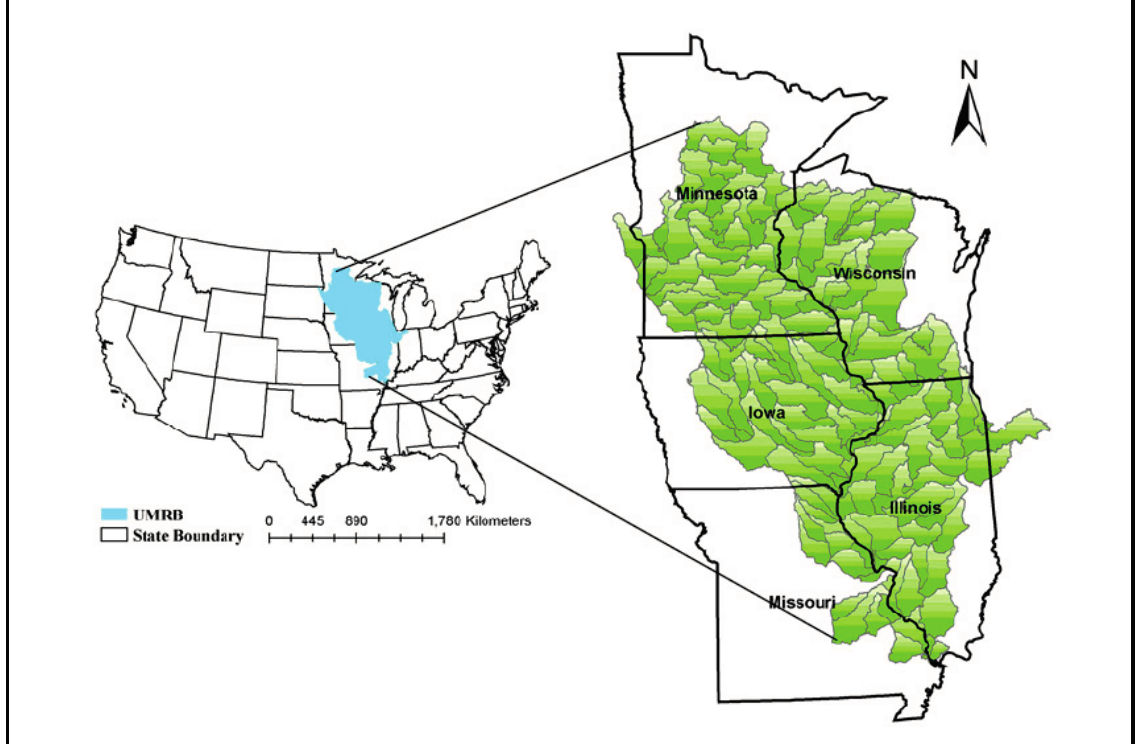
Figure 1. Location of Upper Mississippi River